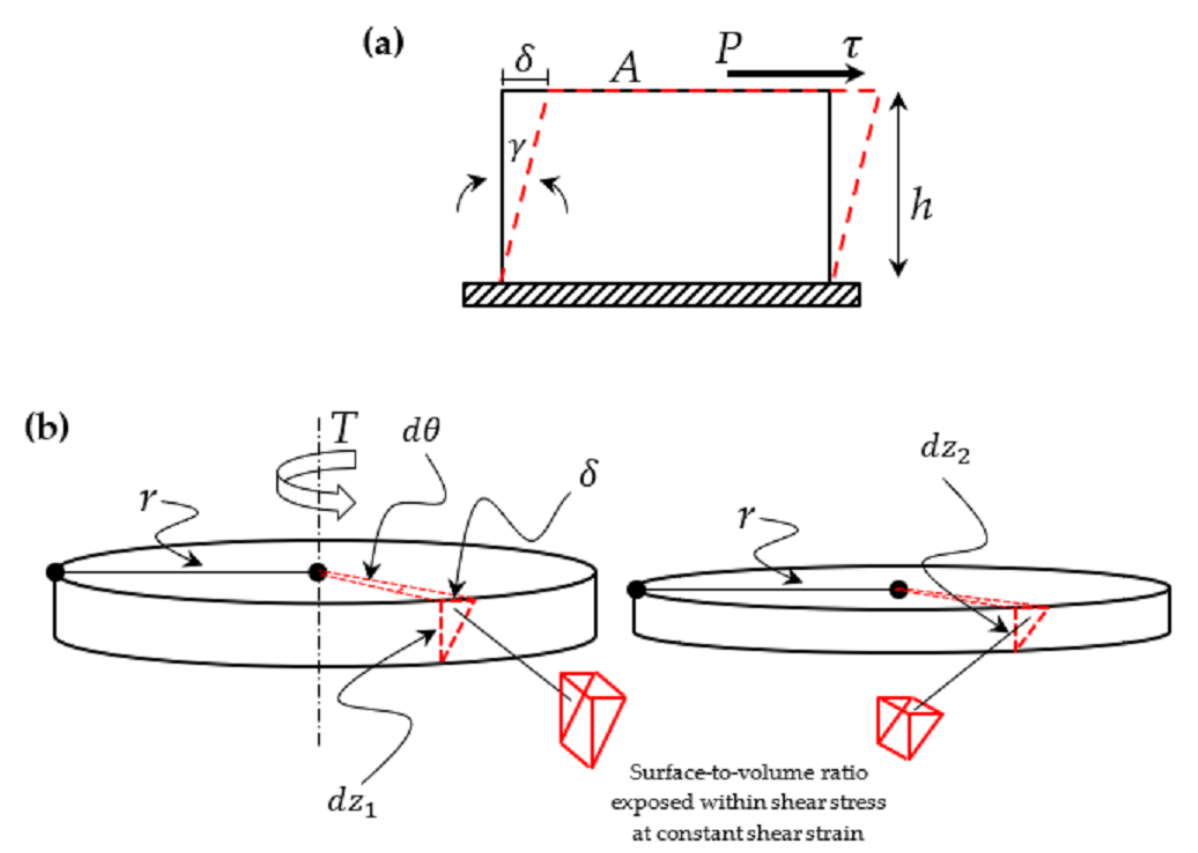
Figure 2. Illustration of shearing deformation by ( a ) the applied force and application area direction, and ( b ) geometrical deformation consideration by torsion and surface-to-volume comparison.